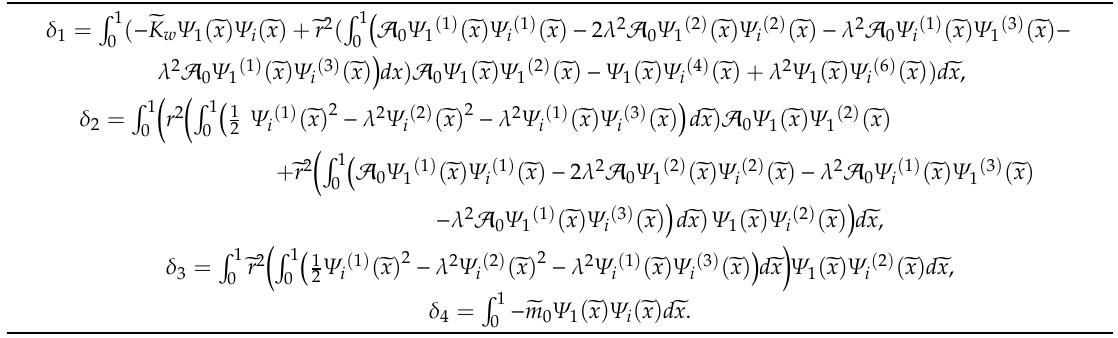
( 1 ) ( (cid:101) x ) − 2 λ 2 A i